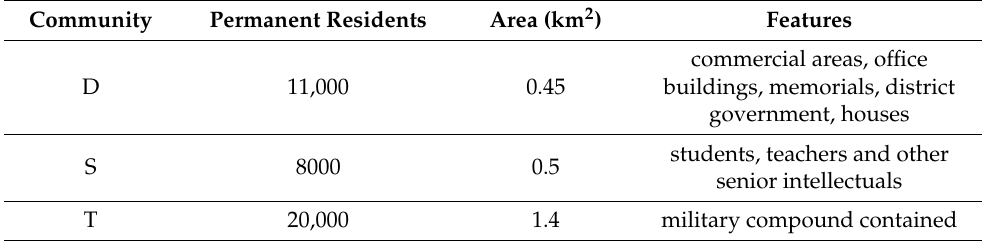
Table 4. Basic information of the